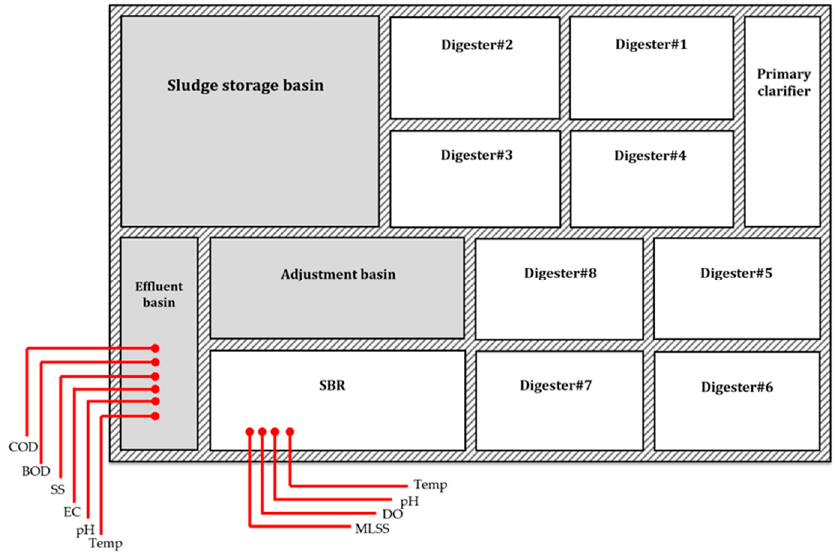
Figure 4. The installation location of the water quality sensors in the wastewater basins.